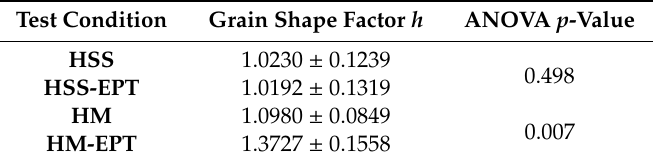
Table 8. Variation in grain shape factor h , at 200 ×